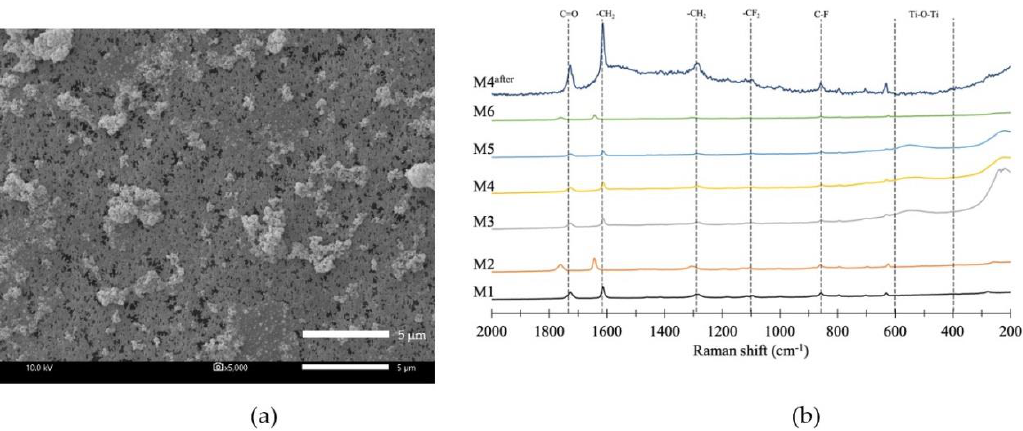
Figure 7. Morphology and functional groups of membrane after pure water flux testing: ( a ) SEM image of M4; and ( b ) Raman spectra of membrane.